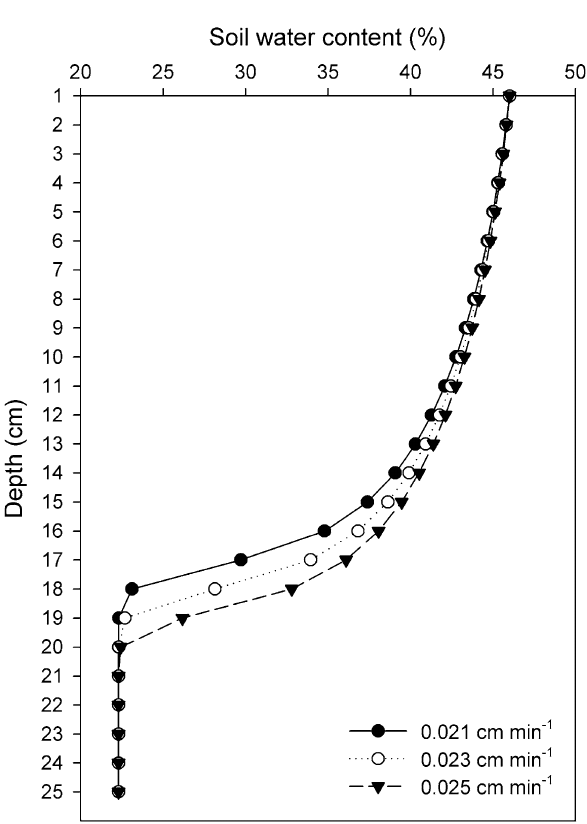
Fig. 6 Changes in simulated soil water content with variations in sat- urated hydraulic